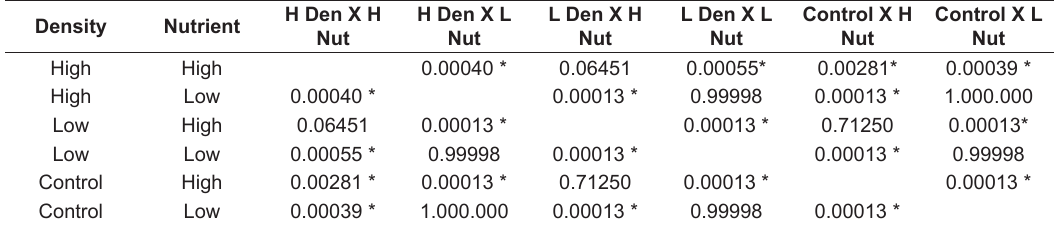
Table 4. Results of Tukey test carried a posteriori of ANOVA two way to verify the difference of density of P. ferrugineum and nutrient on total biomass of A. philoxeroides .